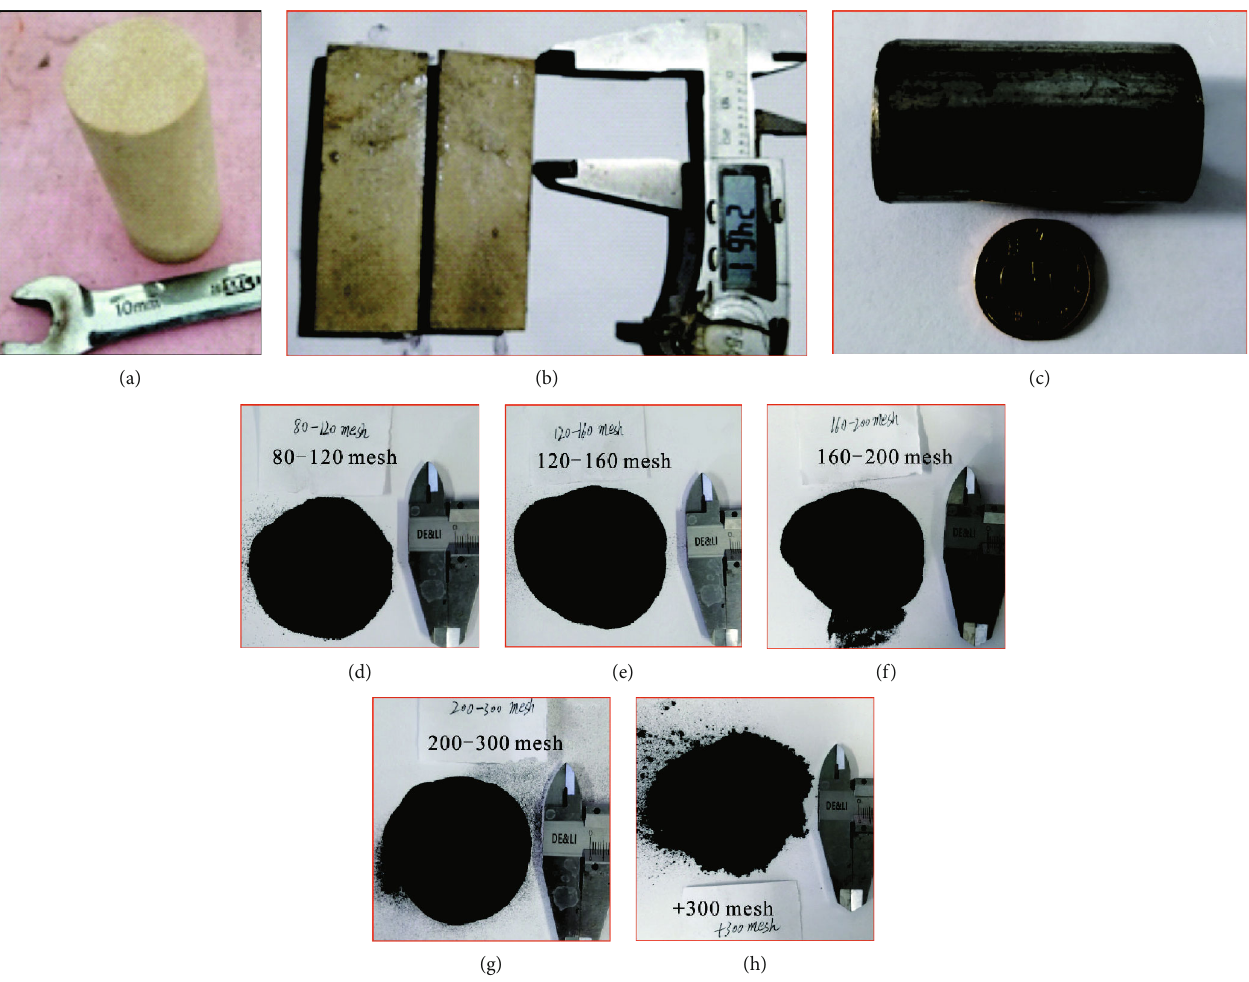
Figure 2: The material of coal fi nes intrusion experiments. (a) The sandstone sample. (b) The fractured sandstone samples. (c) The equipment of coal fi nes. (d – h) Coal fi nes of di ff erent mesh.